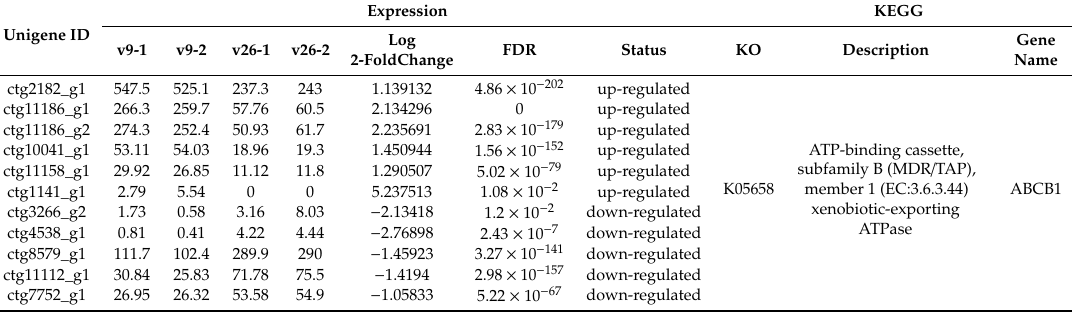
Table 4. DGEs enriched in the pathway of the ABC